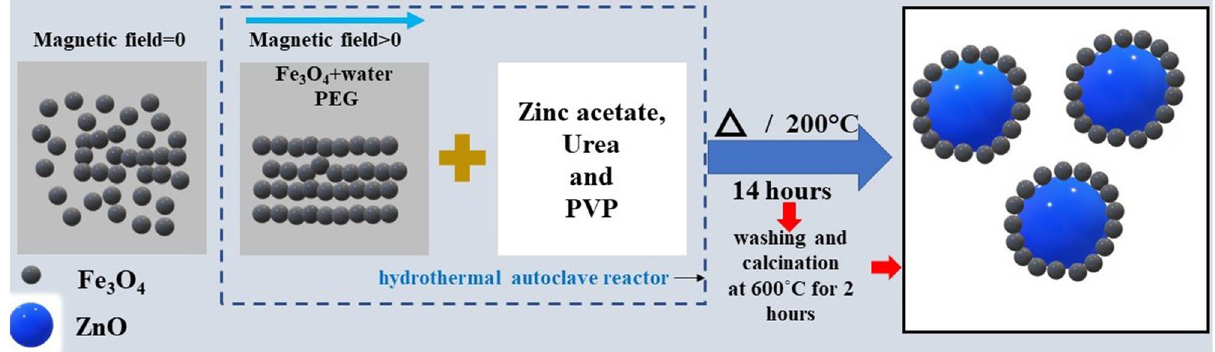
Figure 1. Schematic of the modified hydrothermal process adopted for the synthesis of the Fe 3 O 4 surface decorated ZnO nanocomposite. Fe 3 O 4 nanochains were used as the seed to ZnO